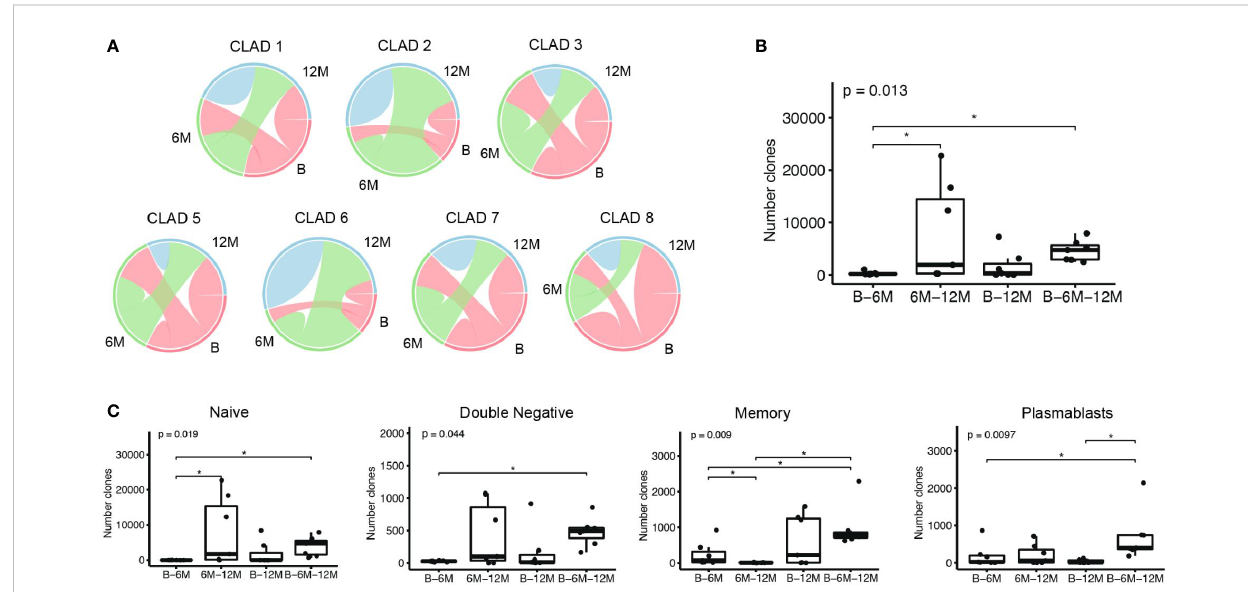
FIGURE 3 Clonal overlap analyses among the different time-points: baseline (B), 6 months (6M) and 12 months (12M) following cladribine treatment. (A) Overlap plots show the proportion of B-cell clones comprising sequences that span over the different time points, and the proportion of clones comprising sequences that are only present in that time point; CLAD4 was excluded from this analysis due to an insuf fi cient sequencing of the naive population. (B) Boxplots show the number of clones that comprise sequences of the de fi ned time points (x axis). (C) Boxplots show the number of clones that comprise sequences at the de fi ned time points (x axis), when considering the B cell subsets individually. P values show Kruskal-Wallis multi-group comparison tests. Asterisks denote Wilcoxon rank-sum paired tests performed if Kruskal-Wallis tests were signi fi cant